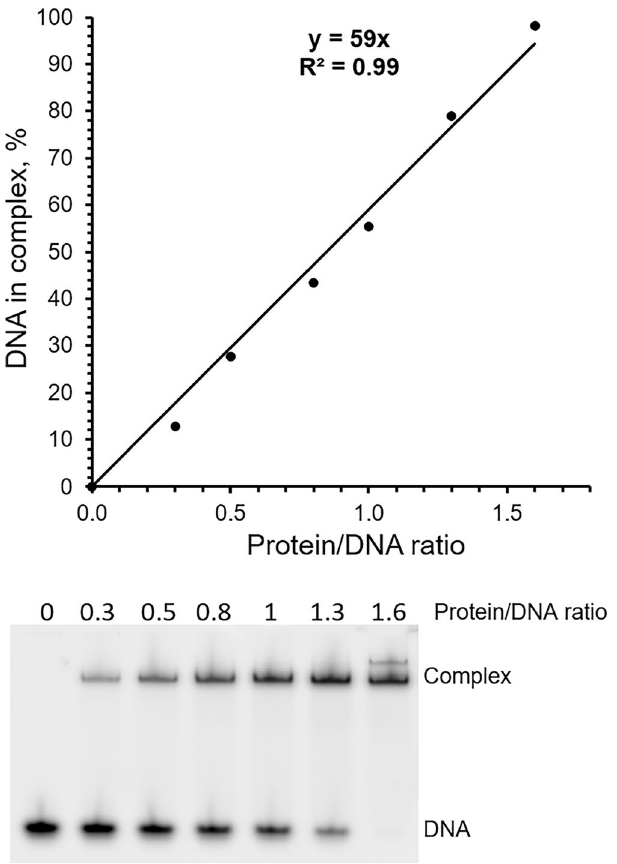
Figure 1. Estimation of the level of active molecules by EMSA. The Cy3-labeled DNA (0.5 µM) was incubated with varying amounts of hPolε CD . Samples were separated by electrophoresis in 5% acrylamide gel and visualized by Typhoon FLA 9500. The percentage of DNA in the complex is plotted against the protein/DNA ratio, and the generated trend line shows the percentage of active molecules capable of DNA binding. The result of one representative experiment is